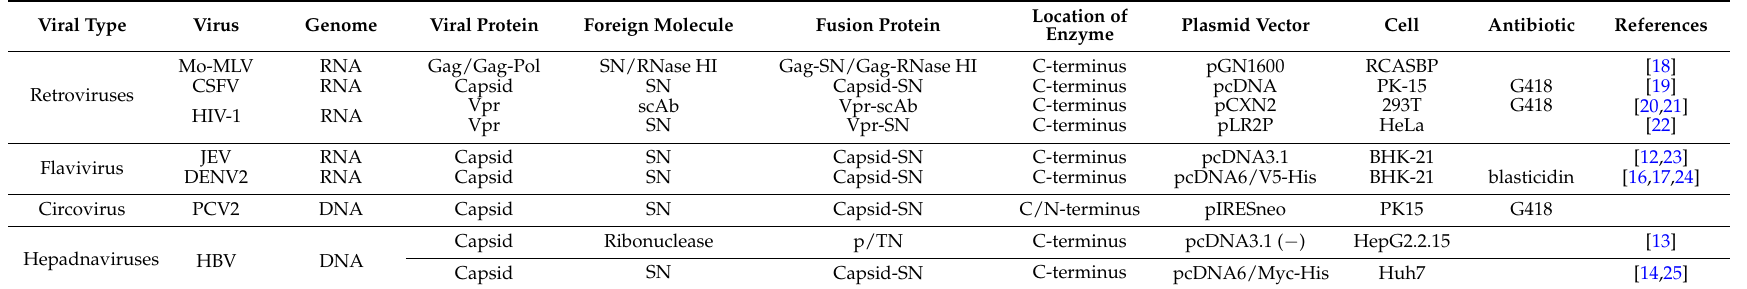
Table 1. Application of CTVI for different types of